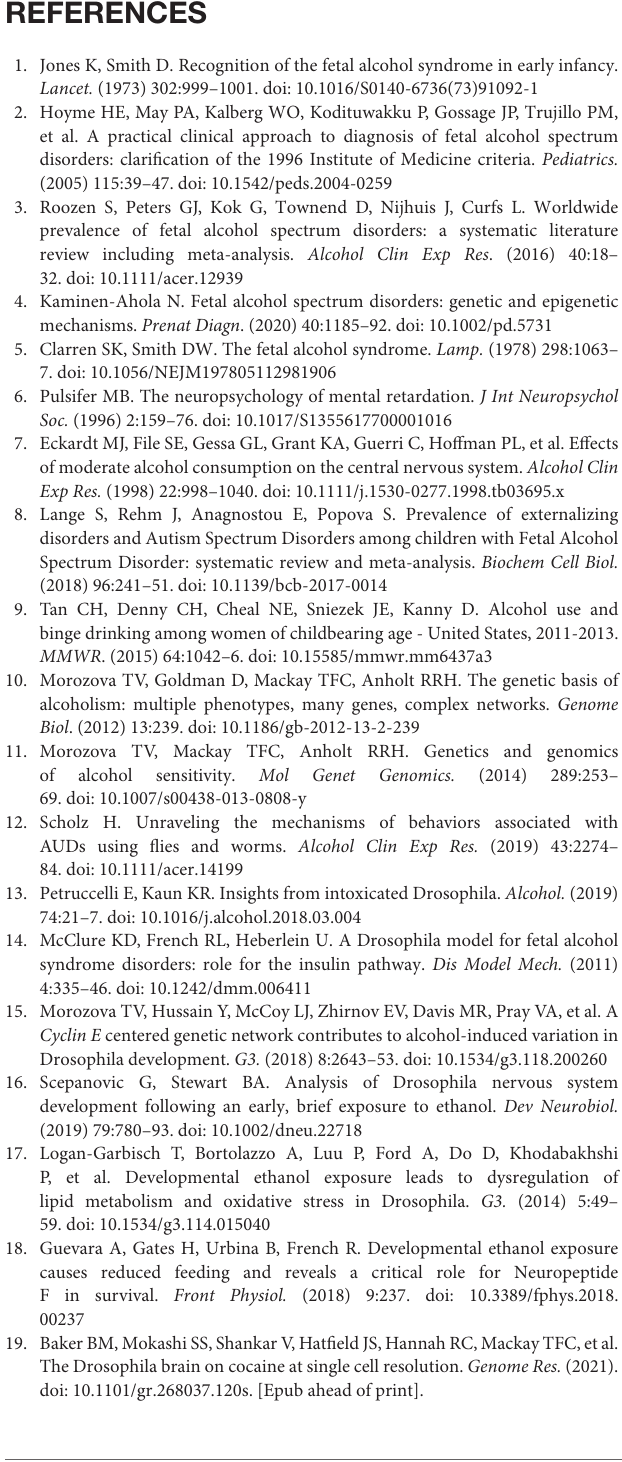
Supplementary Table 8 | Comparison of cell type-specific differentially expressed genes between developmental ethanol exposure and acute cocaine exposure. Meta-comparison sheet contains the mapping of clusters and cell types between the two datasets as well as the methodology and summary of the comparisons. The rest of the sheets contain the list of statistically significantly differentially expressed genes, their Log e fold change values, the calculations of